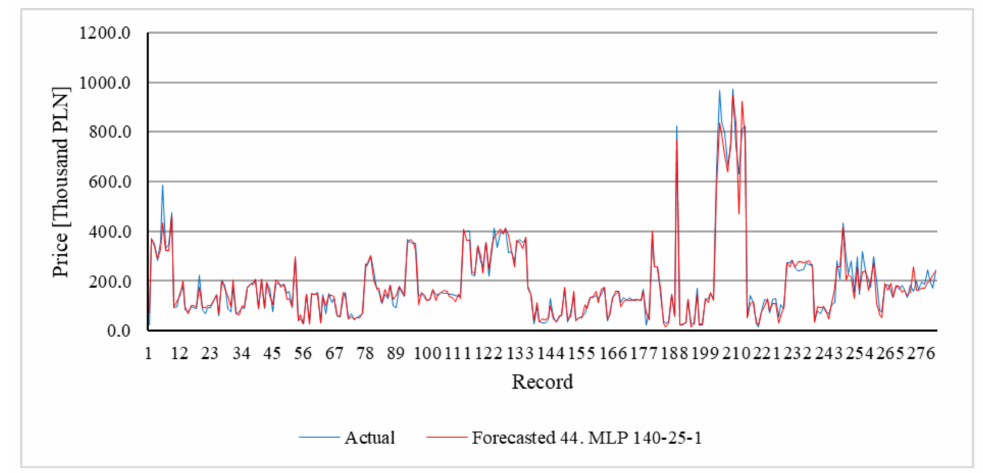
Figure 8. Prediction results for the test set for the Id 44 network (MLP